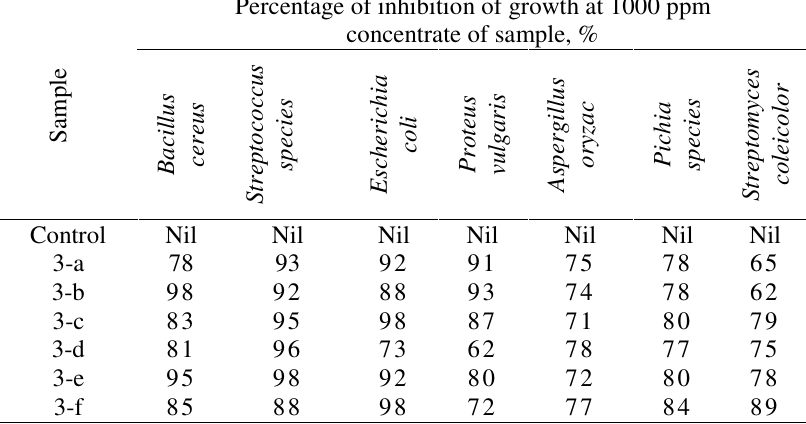
Table 2. Antimicrobial activity of 2 (4-chloro phenyloxy) -4,6- bisaryl hydrazino –1,3,5- triazines (3a to f) Percentage of inhibition of growth at 1000 ppm concentrate of sample,